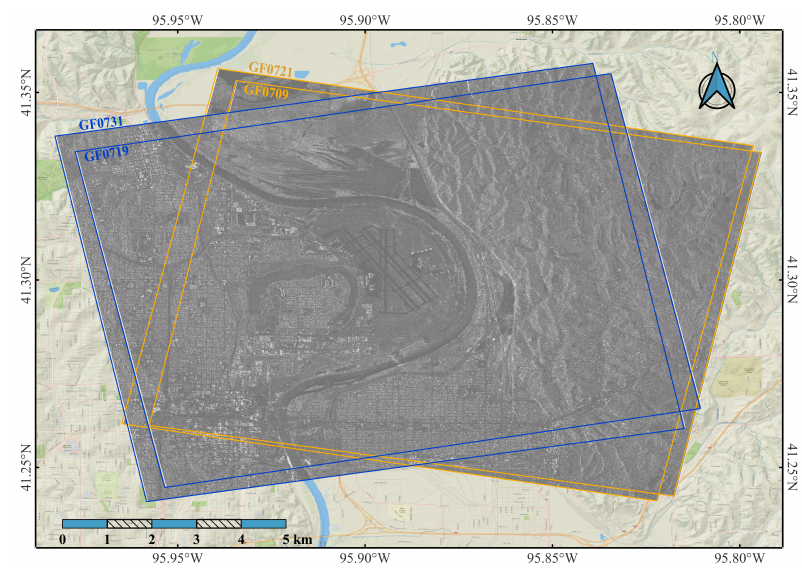
Figure 4. The Omaha datasets of GF-3 stereo images.